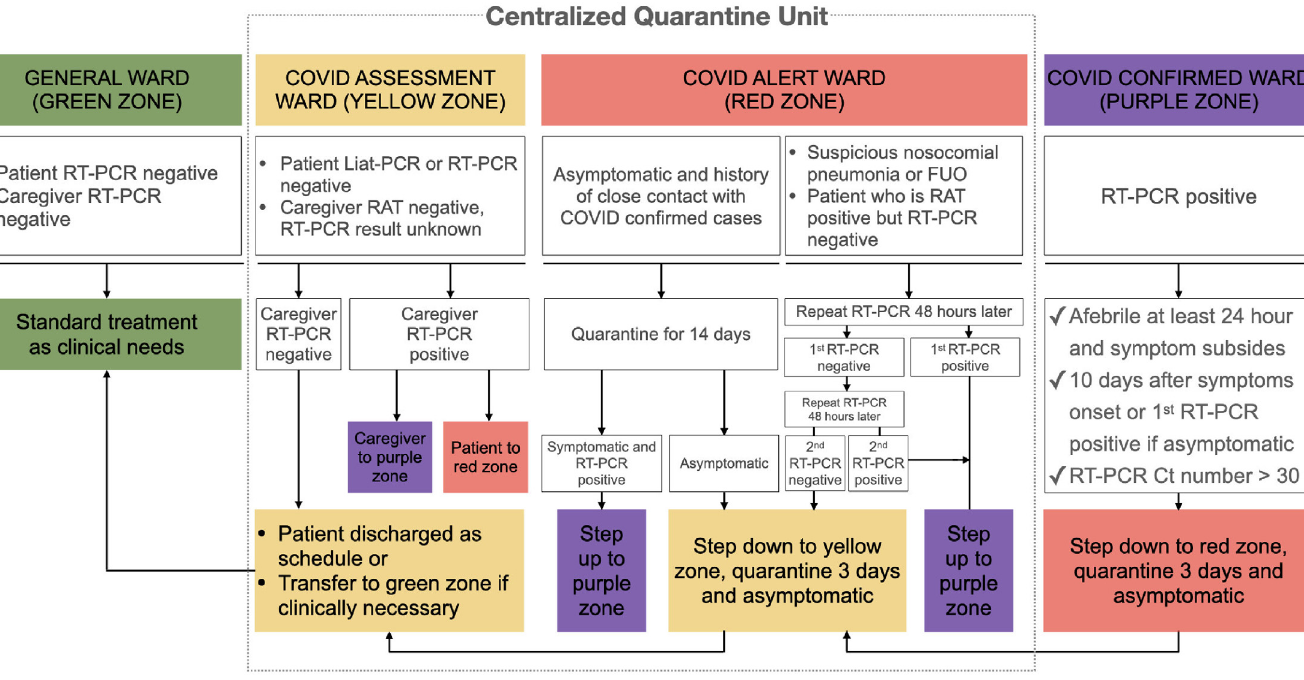
PLOS ONE | https://doi.org/10.1371/journal.pone.0263688 March 9,